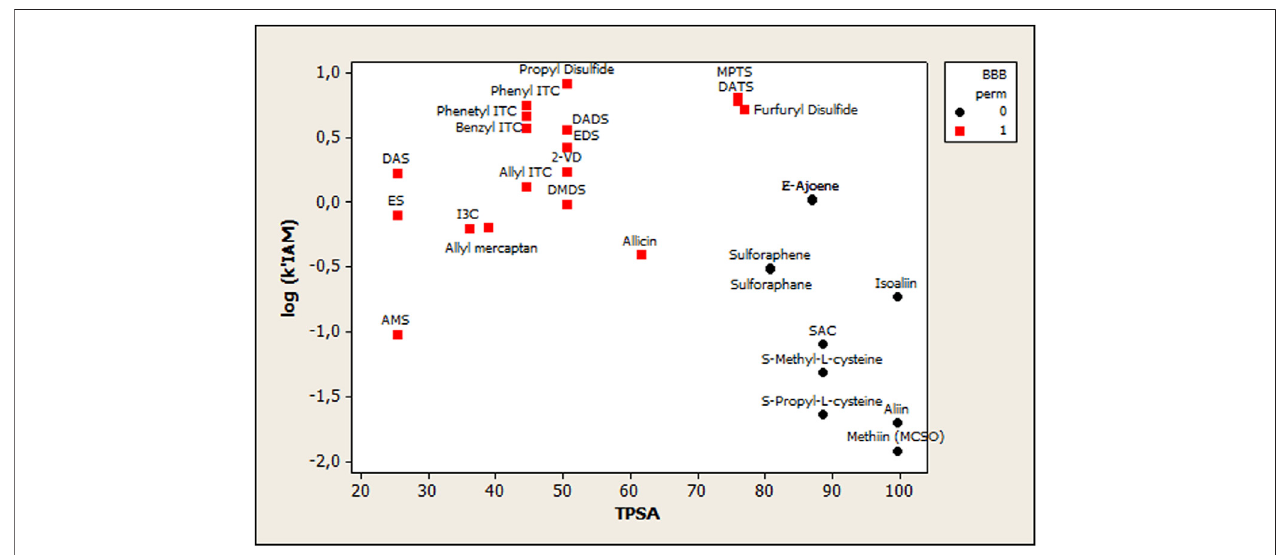
FIGURE5| Scatterplotshowingthe relationship between log k ’ (IAM) vs. TPSA,considering OSC distribution using BBBpermeation asthe grouping classi fi cation variable. BBB permeating organosulfur compounds (group 1), and BBB not-permeating organosulfur compounds (group 0).